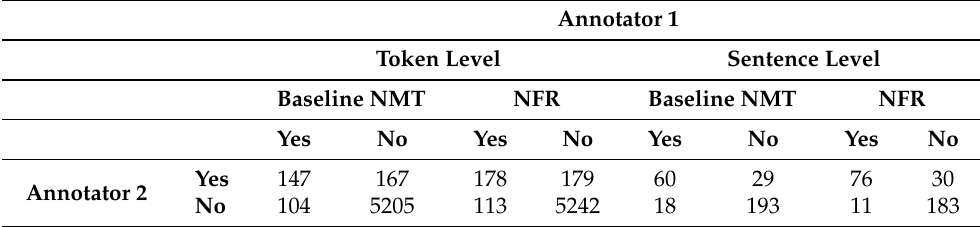
Table A3. Confusion matrix error detection at token and sentence level, for baseline NMT and NFR system.